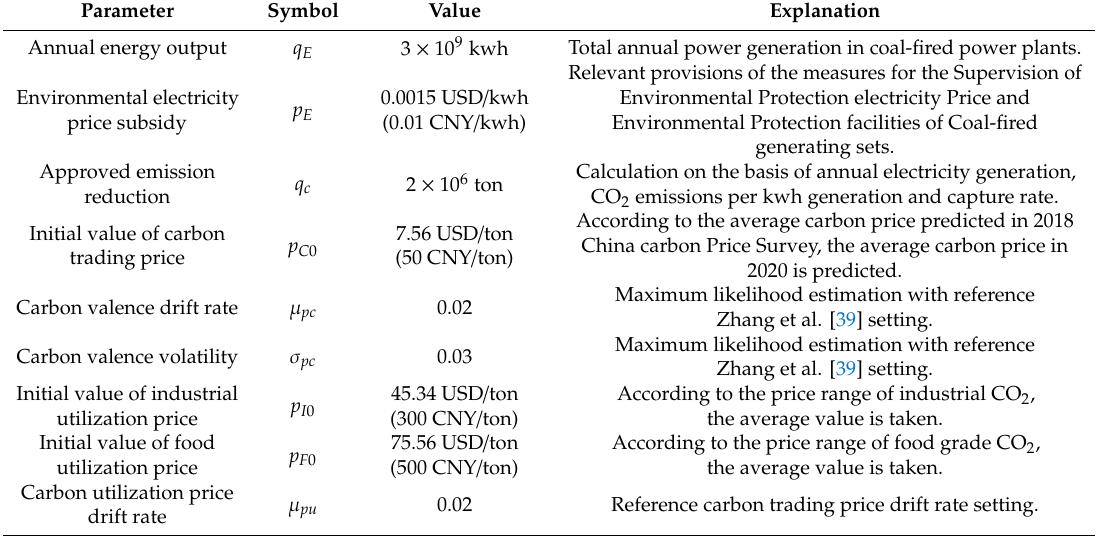
Table 1. Setting of related parameters of the CCUS investment project in a coal-fired power